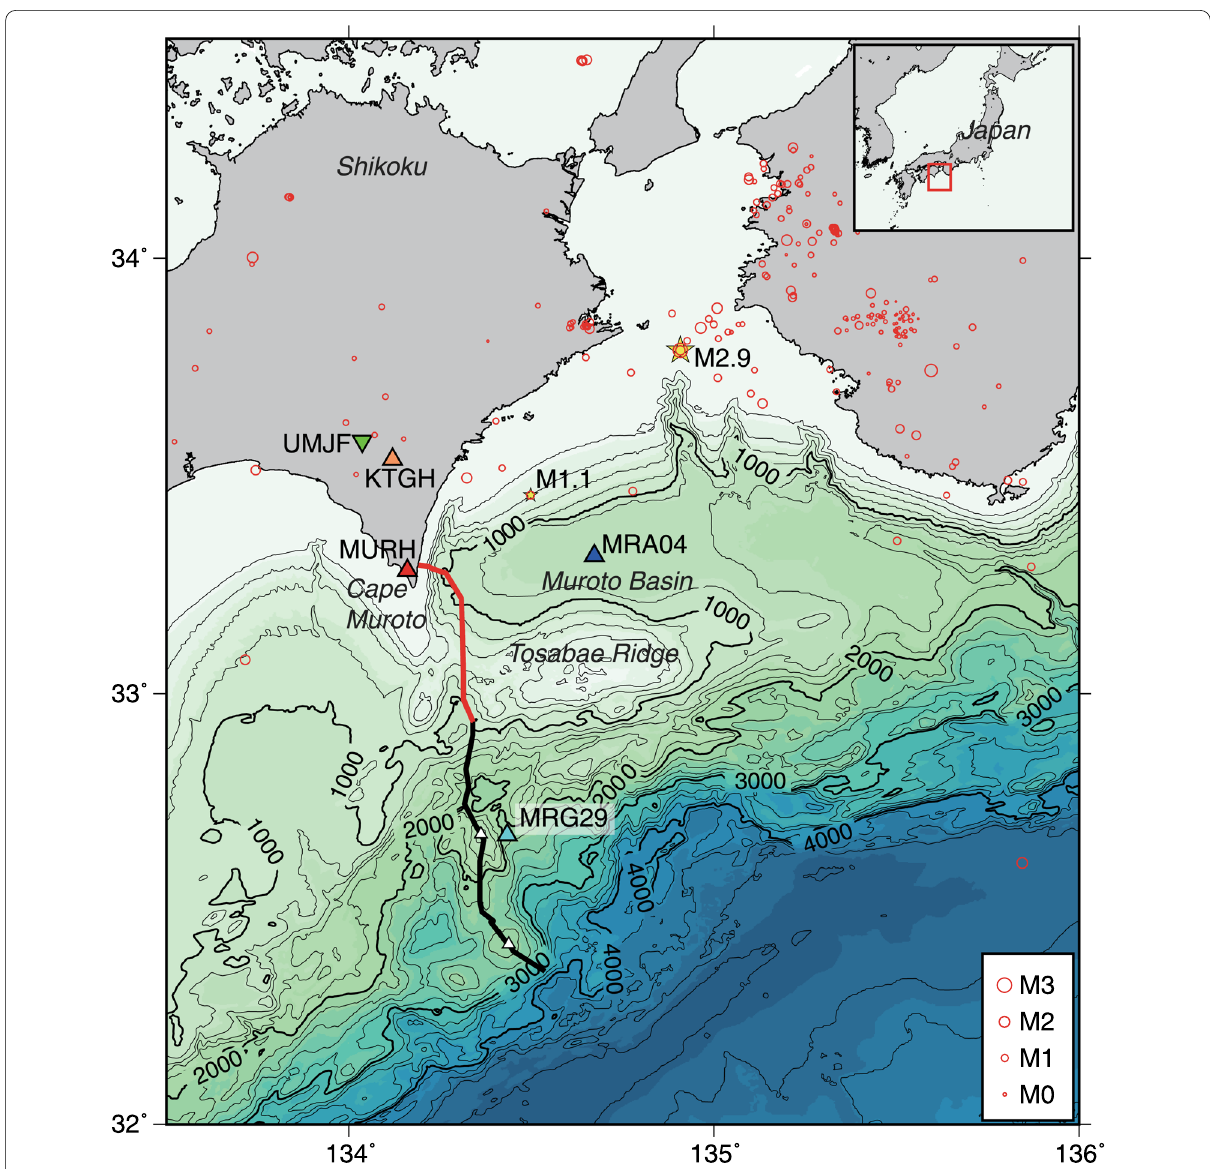
Fig. 1 Locations of the seafloor fiber-optic cable and hypocenter distribution during the observation period. The bold line represents the cable route of the Comprehensive Seafloor Monitoring System off Cape Muroto, with the red section indicating the 50-km-long DAS observation section. The two small open triangles along the cable show the ocean-bottom seismometer locations. The triangles with different colors are the stations that were used for a comparison with the DAS observations: MURH and KTGH (Hi-net), UMJF (F-net), and MRA04 and MRG29 (DONET2). Red circles indicate the epicenters of earthquakes that occurred during the January 27–31, 2020 (JST), period, as determined by the Japan Meteorological